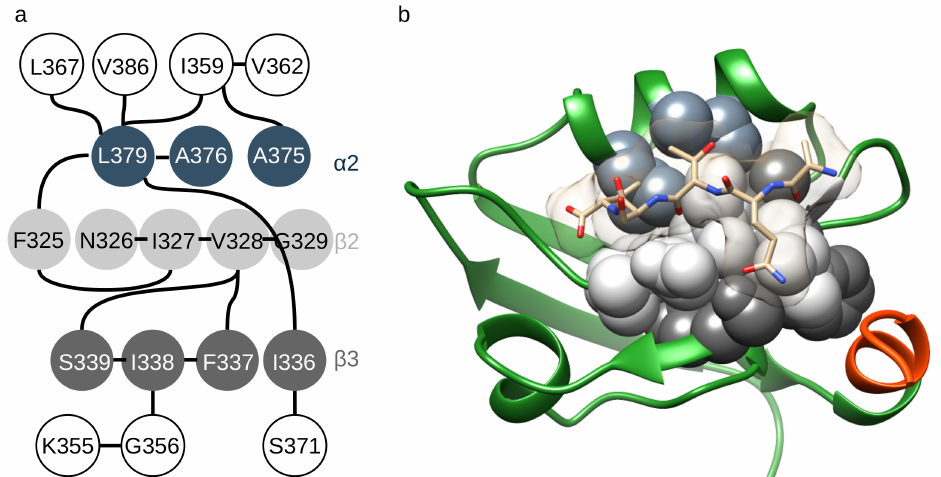
Figure 4. Residue contact network including contacts with discriminative power between two of the four possible states defined by ligand binding and presence of helix α 3. ( a ) network displayed emphasizing the role of residues in β 2, β 3 or α 2. ( b ) structural representation of the residues in the network and residing in the secondary structure elements mentioned ( β 2: light gray, β 3: dark gray, α 2: slate gray). Figure rendered with UCSF